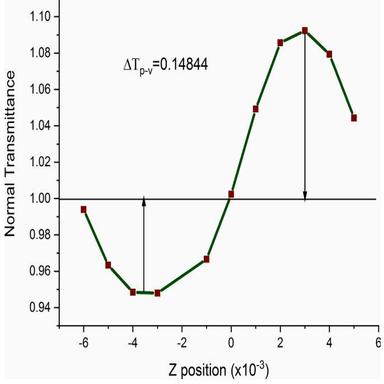
SELF-FOCUSING (CLOSED APERTURE) Z-SCAN PLOT